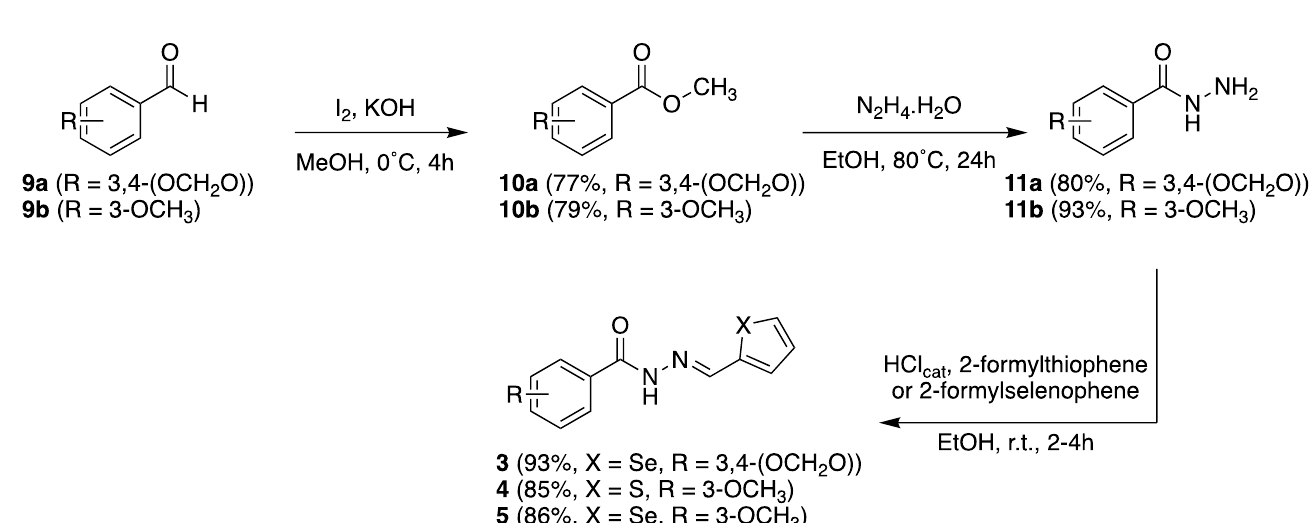
Scheme 1. Synthetic scheme for preparation of N -acylhydrazonic compounds 3 , 4, and 5 . Reaction conditions and yields leading to NAH compounds 3 – 5 .